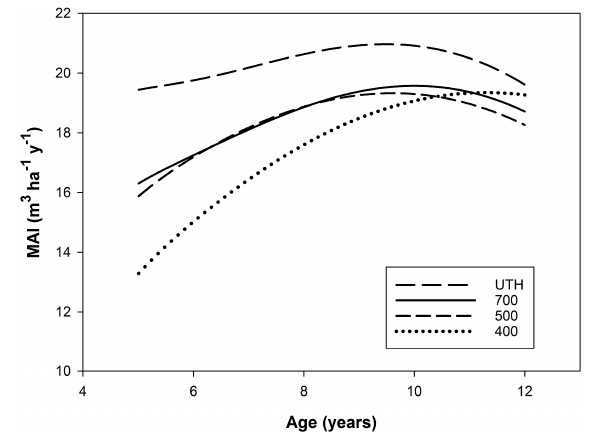
Figure 3. Mean annual increment (MAI) curves by stocking treatment.